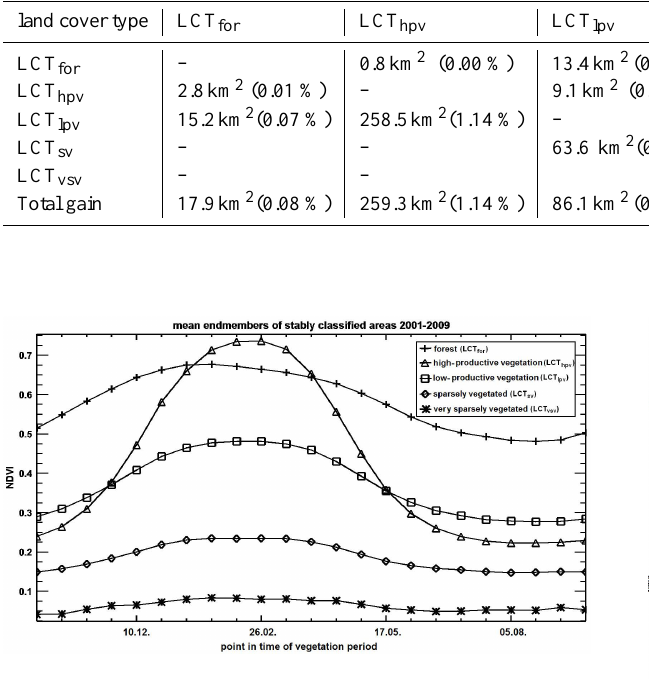
Fig. 10. NDVI percentiles (5%, 25%, 50%, 75%, 95%) for sta- bly classified areas (black) and all classified areas (grey) of land cover types forest/ LCT for (a) , very sparsely vegetated/ LCT vsv (b) , low-productive vegetation/ LCT lpv (c) , high-productive vegetation/ LCT hpv (d) and sparsely vegetated/ LCT sv (e) .